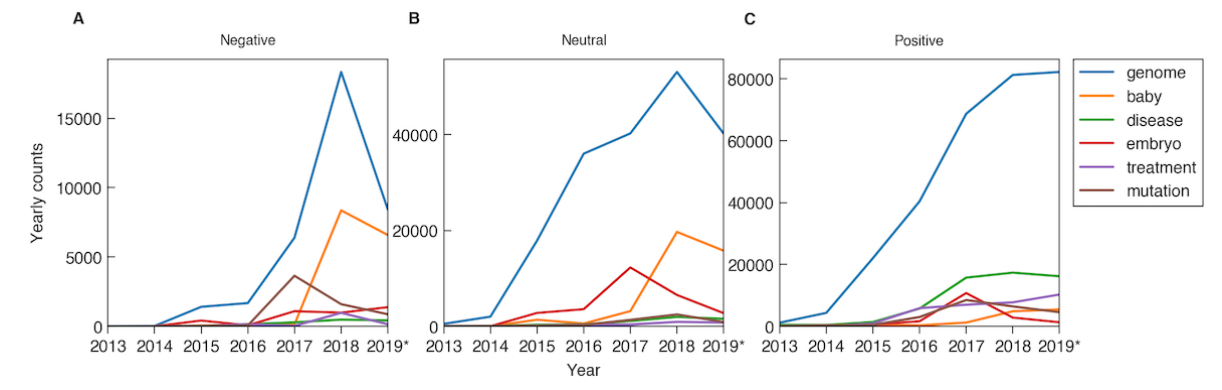
Figure 5. Yearly occurrences of themes. Multiple themes with distinct regex patterns were matched to the text of tweets, and the 6 most frequent themes were selected. Panels A, B, and C show the yearly counts of themes when grouped by negative, neutral, and positive sentiment, respectively. For the year 2019, the counts were extrapolated from the months before June to a full